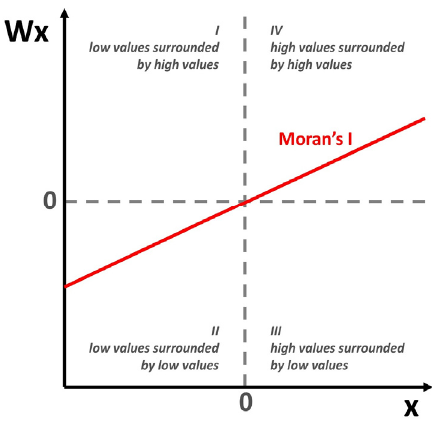
Figure 1. Anselin‘s Moran scatter plot interpretation guide. ( Source: Authors’ elaboration on [51] ).